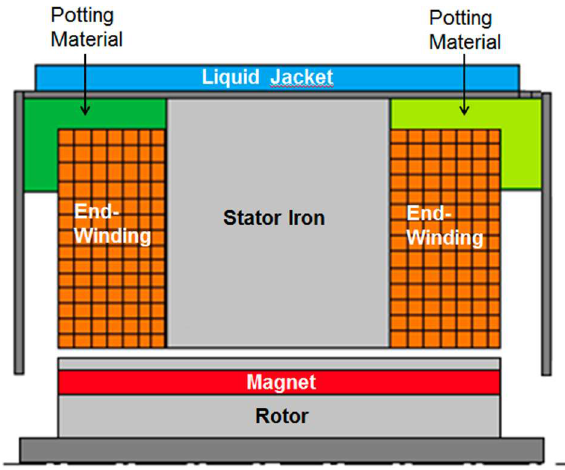
Figure 6. A permanent magnet motor with potting materials [30].